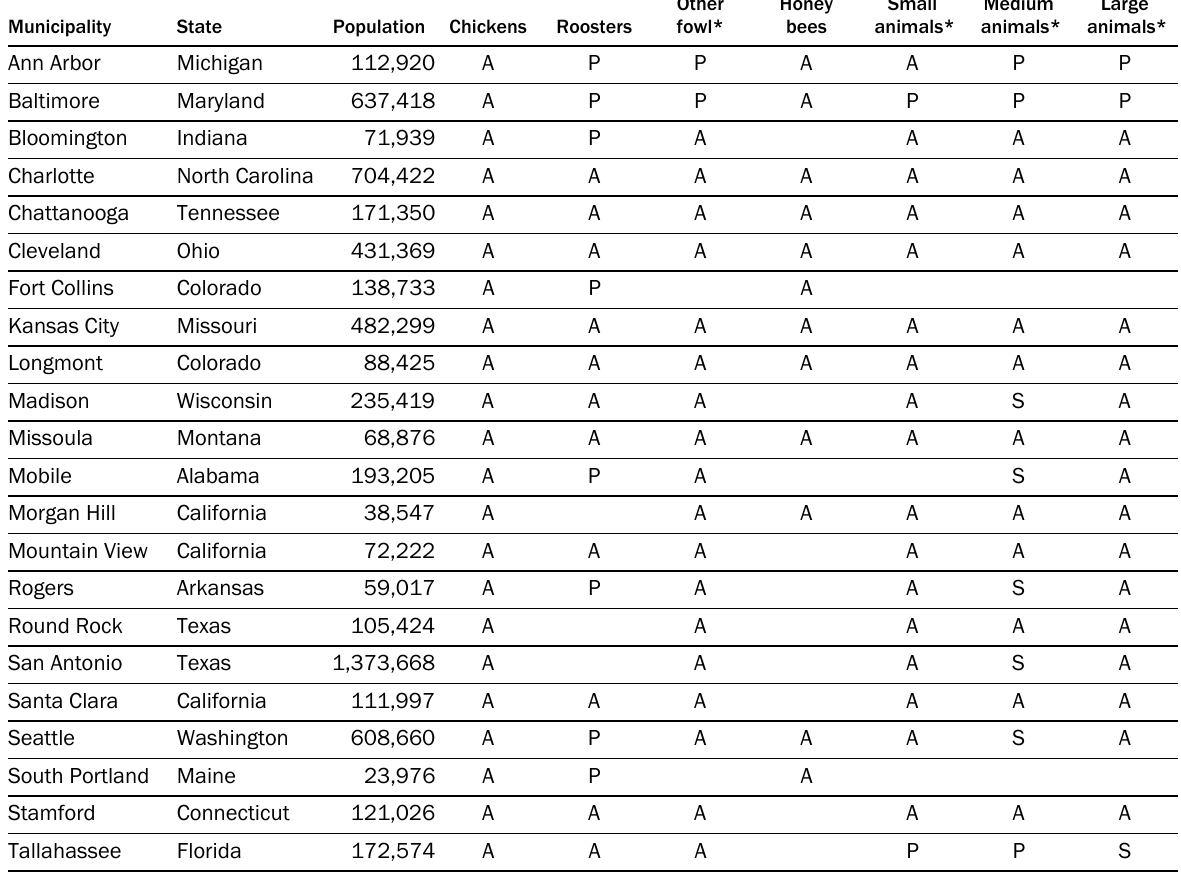
Table 1. Livestock Type Prohibitions in Sample (P=prohibited, A=allowable, S=some in category allowed, blank=none specified or